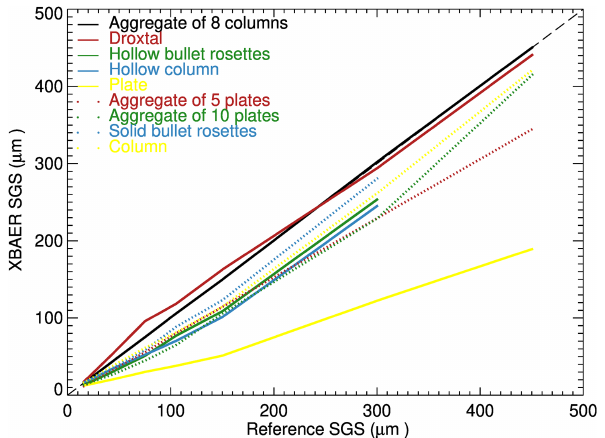
errors – the black line with dots indicates the 0 difference for accu- rate SGS for aggregate of 8 columns, and the grey area indicates the relative error in SSA introduced by a 16% error in SGS; (b) SPS se- lection – different color and line styles indicate different SPSs used in the calculation of SSA while the true SPS is set to be “plate” or other convex